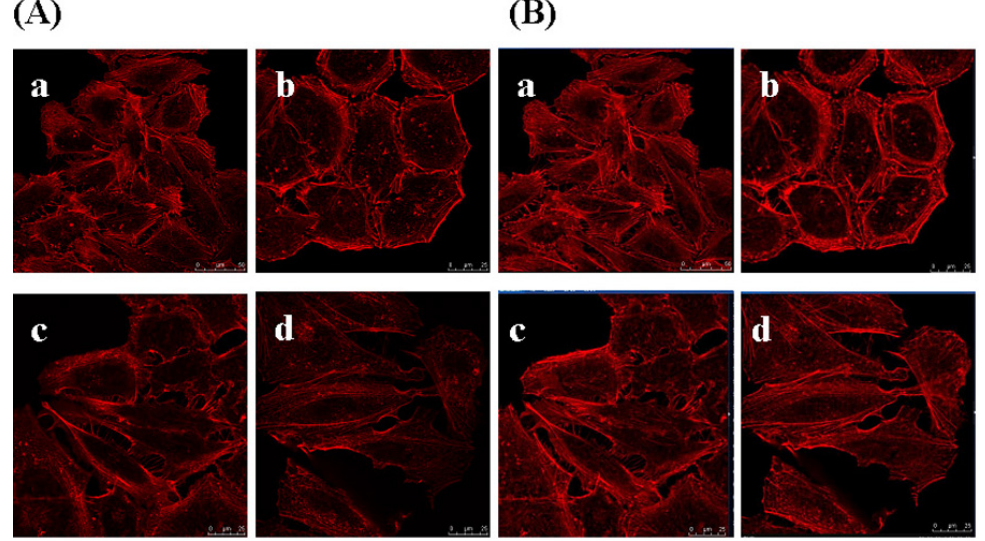
Figure 8. Effect of Gekko sulfated glycopeptides on actin filament. Cells were incubated with the phalloidin rhodamine and photographed under oil microscope (600×). ( A ) Sectional images (on the left); ( B ) 3-dimensional images (on the right). ( a ) Control group; ( b ) 10 µg/mL Gekko sulfated glycopeptides; ( c ) 100 µg/mL Gekko sulfated glycopeptides and ( d ) 200 µg/mL Gekko sulfated glycopeptides.